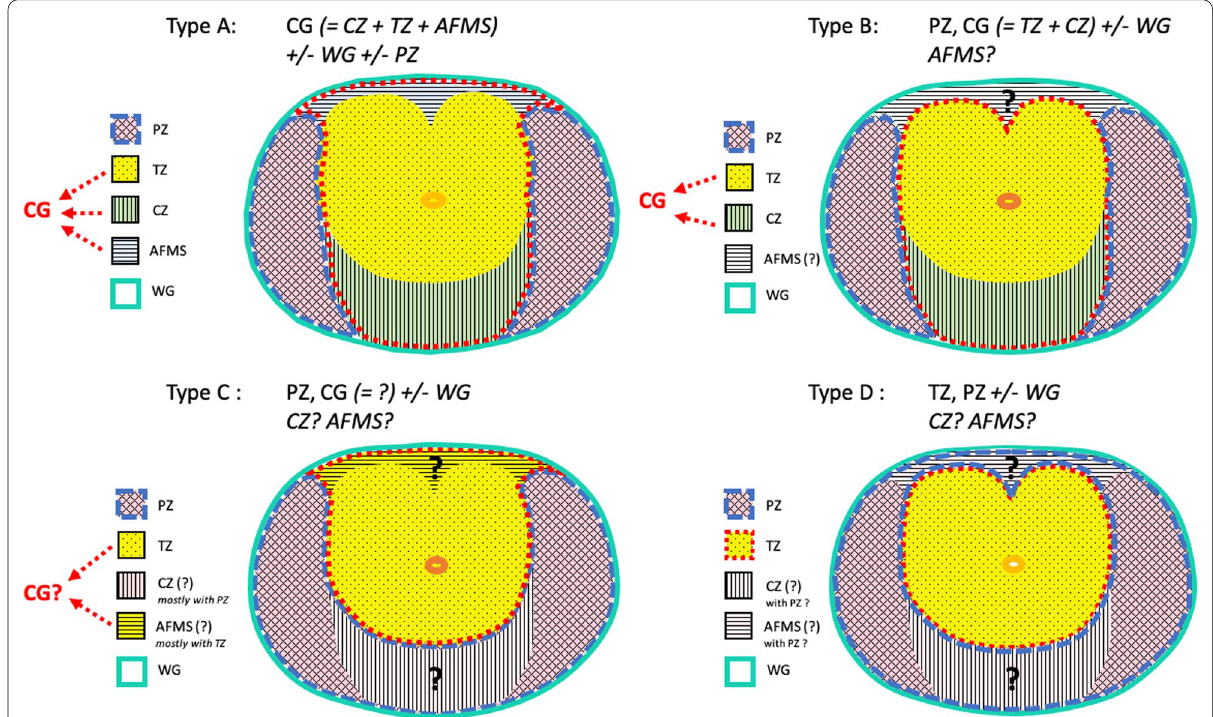
Fig. 3 Schematic of the four major types of protocol of zonal segmentation. Type A: articles for which “central gland” included CZ, TZ and AFMS. Type B: articles for which “central gland” included TZ and CZ. No details for AFMS. Type C: articles which did not provide details for AFMS, CZ or CG. CZ seemed to be mostly segmented PZ, while AFMS seemed to be mostly segmented with TZ, usually called “CG”. Type D: articles which did not provide details for AFMS or CZ. CZ and AFMS seemed to be mostly segmented with PZ. CZ central zone, TZ transition zone, AFMS anterior fibro‑muscular stroma, PZ peripheral zone, CG central